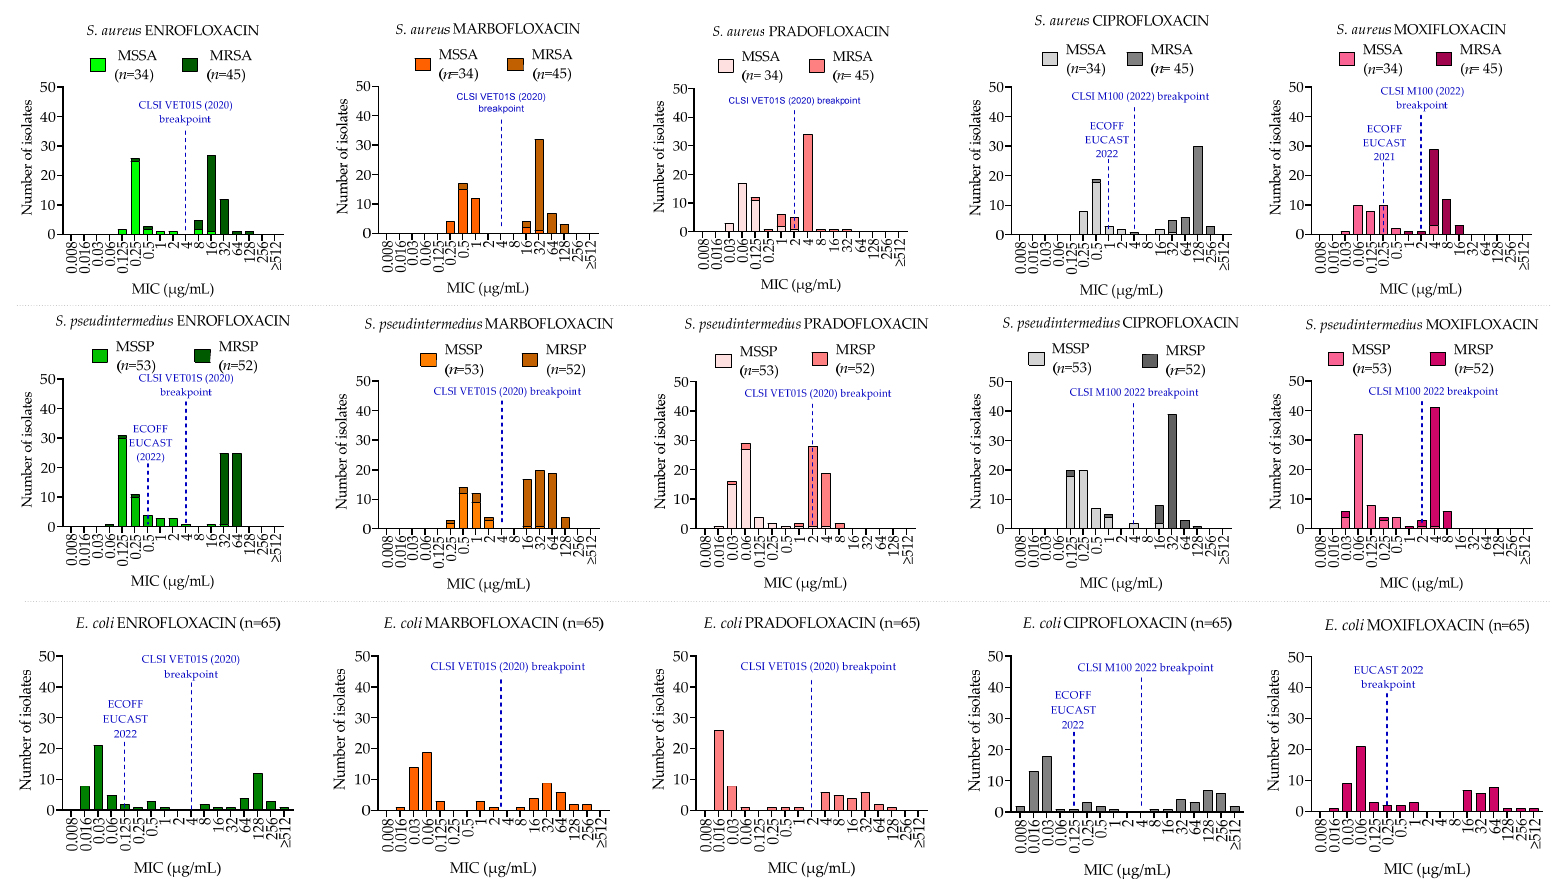
Figure 1. MIC distributions in S. aureus (first row), S. pseudintermedius (second row) and E. coli (third row) of five fluoroquinolones. Blue-dotted lines indicate the clinical breakpoint, the highest MIC value considered susceptible, and the epidemiological cut-off (ECOFF), the MIC value that separates wild-type from non-wild-type bacteria.